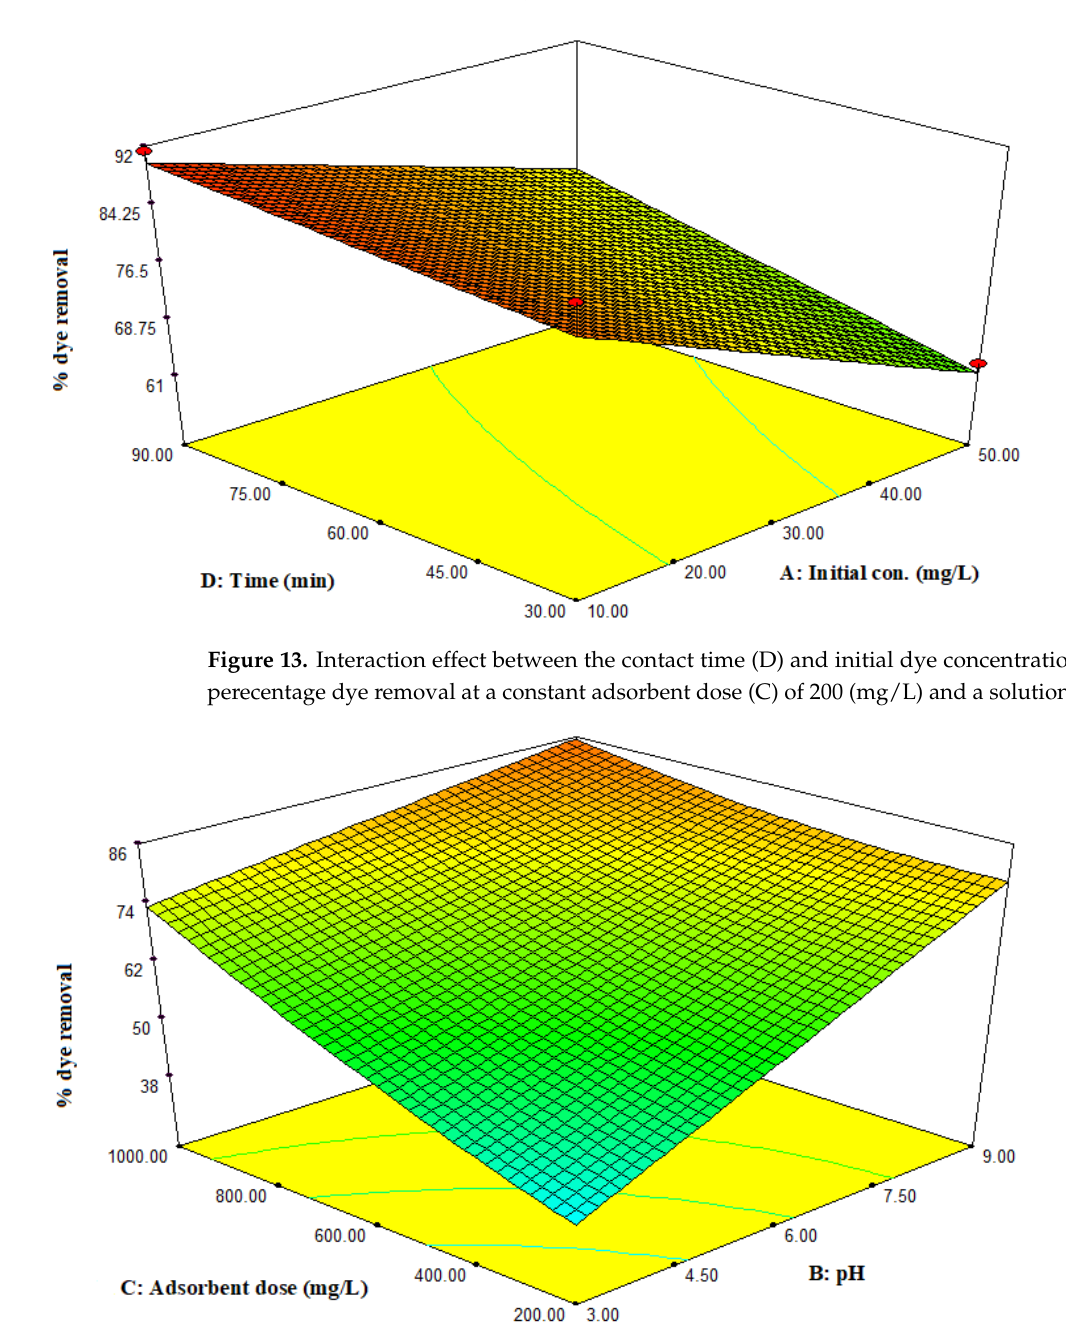
Figure 14. Interaction effect between the solution pH (B) and adsorbent dose (C) on the perecentage dye removal at a constant initial dye concontration (A) of 38.19 (mg/L) and contact time (D) of 89.75 min.